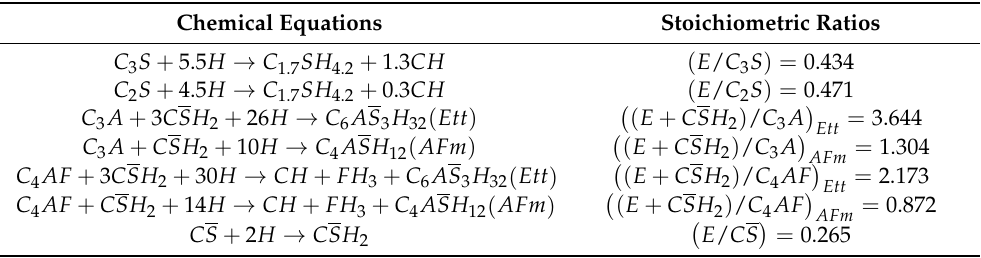
Table 5. Chemical equations and corresponding stoichiometric ratios used for the modelling of hydration of